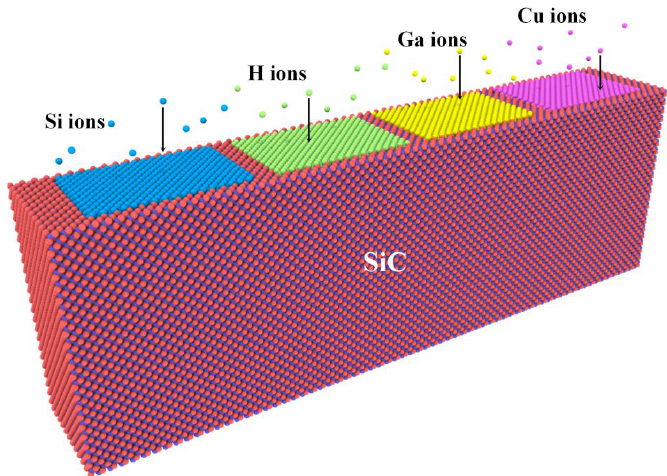
Figure 4. The typical ion implantation simulation model of SiC